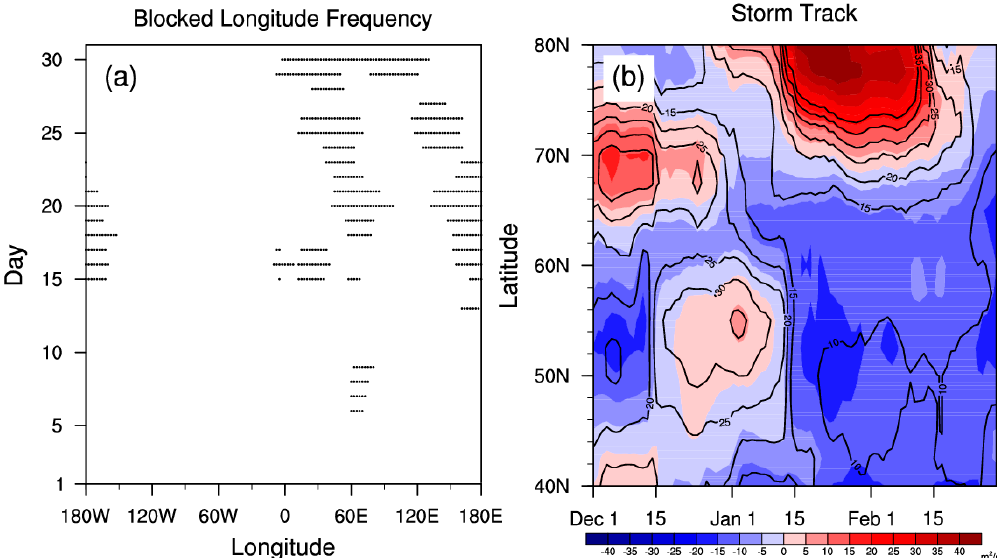
Figure 1. ( a ) Zonal distribution of blocking regions from 1 to 31 January 2012. ( b ) time–latitude cross-section of the 15-day running-mean storm tracks (contour interval, 5 m 2 · s − 2 ) and their anomalies (shaded) averaged over 40–70 ◦ E from December 2011 to February 2012 in observations. Labels on the time axis are the central day of the 15-day moving window.